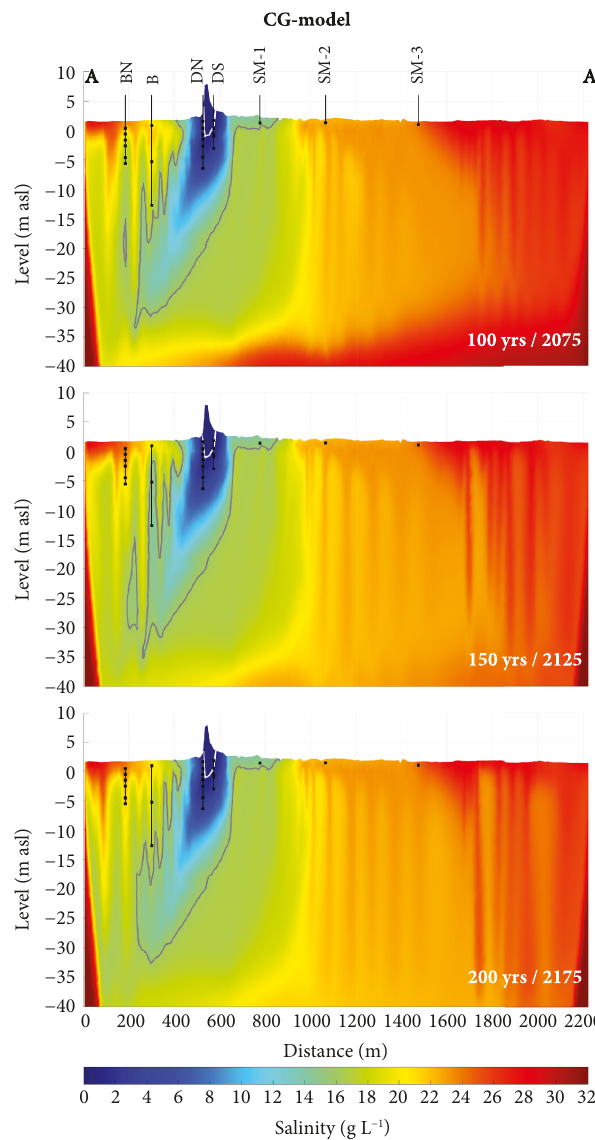
Figure 6: Predicted groundwater salinity distribution along cross-section A-A ’ without further geomorphological changes (CG-model) after a simulation time of 100 yrs (top row), 150yrs (2 nd row), and 200 yrs (bottom row). The 1 gL -1 (white line) and the 16gL -1 (i.e., 50% seawater, gray line) contour lines are